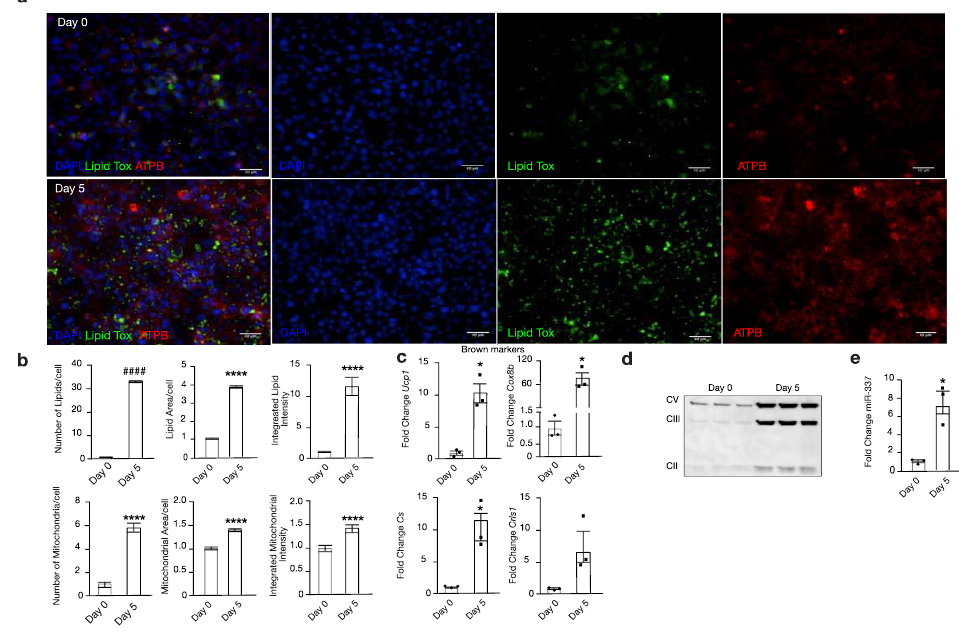
Figure 2. miR-337-3p is upregulated in browning. ( a ) Representative microscopic images of immunofluorescent stainings from day 0 and day 5 of mouse brown adipocyte di ff erentiation for mitochondria (red) ATPB, lipid droplets (green) Lipidtox, and nuclear (blue) DAPI. The scale bar in the figures corresponds to 40 µ m. ( b ) Quantifications of number, integrated intensity, and area of mitochondria and lipids corrected per cell of day 0 and day 5 of mouse brown adipocyte di ff erentiation. (n = 6 per group) ( c ) RT-PCR analysis of BAT thermogenic and mitochondrial markers, Ucp1 , Cox8b , Cs , and Crls1 of day 0 and day 5 of mouse brown adipocyte di ff erentiation. L7 mRNA was used as an internal normalizer to the number of mRNA transcript copies. n = 3 per group. ( d ) Western blot analysis of Complex V (ATP5A-55kDa), III (UQCRC2-48 kDa), and II (SDHB-30kDa) of the electron transport chain of OXPHOS in day 0 and day 5 of mouse brown adipocyte di ff erentiation. ( e ) RT-PCR analysis of mmu-miR-337-3p in day 0 and day 5 of mouse brown adipocyte di ff erentiation, normalized to U6 RNA. N = 3 / group. All immunofluorescent quantifications are presented as medians ± SD, while quantifications of RT-PCR analysis are presented as means ± SEM, and individual data points are given by the dot plot. An Independent sample t -test was used to assess di ff erences in expression levels. * p < 0.05; **** p < 0.0001 by Independent sample t -test, equal variances not assumed. #### p < 0.0001 Independent sample t -test equal variances assumed. n, number of biological replicas; ATPB, β -subunit of ATP synthase; Ucp1 , uncoupling protein-1; OXPHOS, oxidative phosphorylation; Cox8b , cytochrome C oxidase subunit 8b; Cs , citrate synthase; Crls1 , cardiolipin synthase